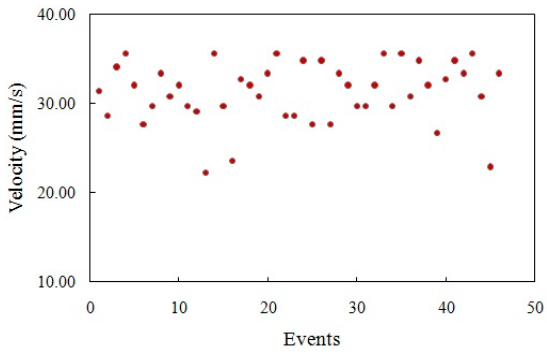
Figure 11. The velocities of the microspheres in the main microchannel for sample and sheath pressure values of 50 and 65 mbar, respectively.